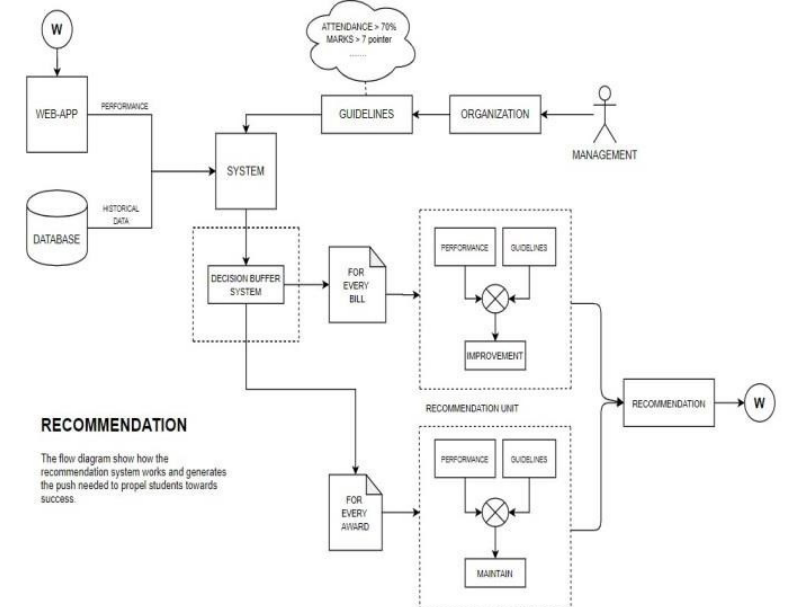
Figure 2. Overview of decision bu ff er system. Figure 1. Overview of stick carrot model. Figure 3. Overview of recommendation system 2.4 The FPP